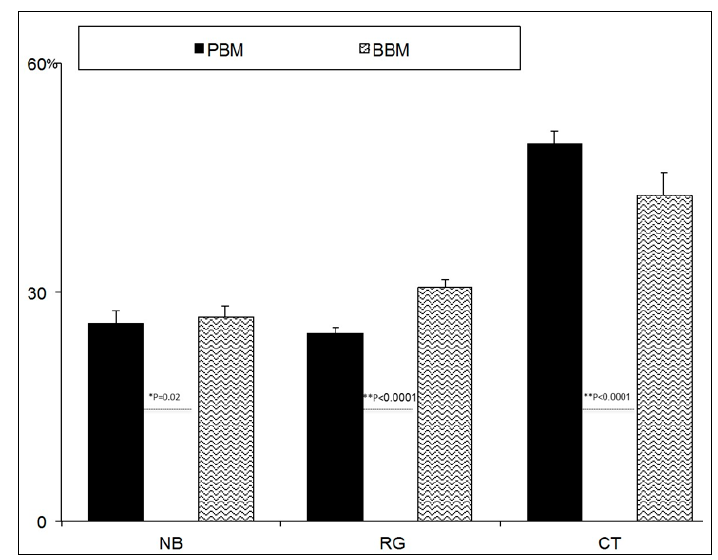
Figure 8. Histomorphometric measurements on bone biopsies. Histomorphometry shows the percentage of newly formed bone, marrow spaces and the residual grafted material. The figure provides the mean and SD values for all the parameters in each group. Statistically significant differences were seen when comparing BBM and PBM in relation to NB (new bone) (Mann–Whitney test, * p = 0.02), RG (residual graft material) (Mann–Whitney test, ** p < 0.0001), and CT (connective tissue) (Mann–Whitney test, ** p < 0.0001).